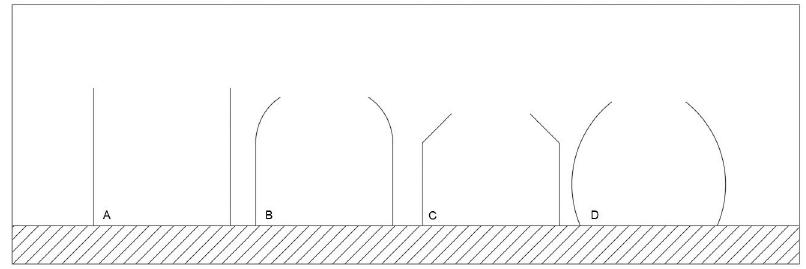
Figure 1. Different shapes of noise barriers